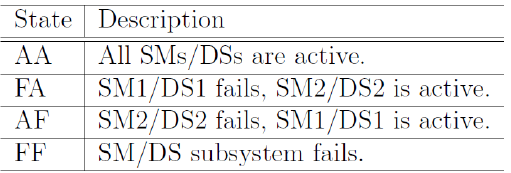
Table 3. The states of SM/DS